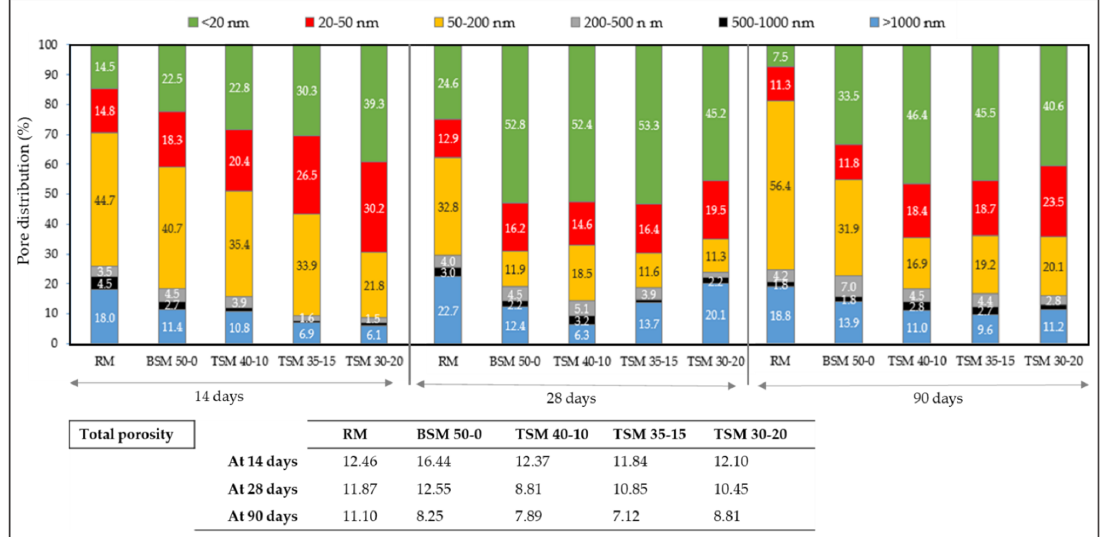
Figure 9. Total porosity and pore size distribution at 14, 28, and 90 days.